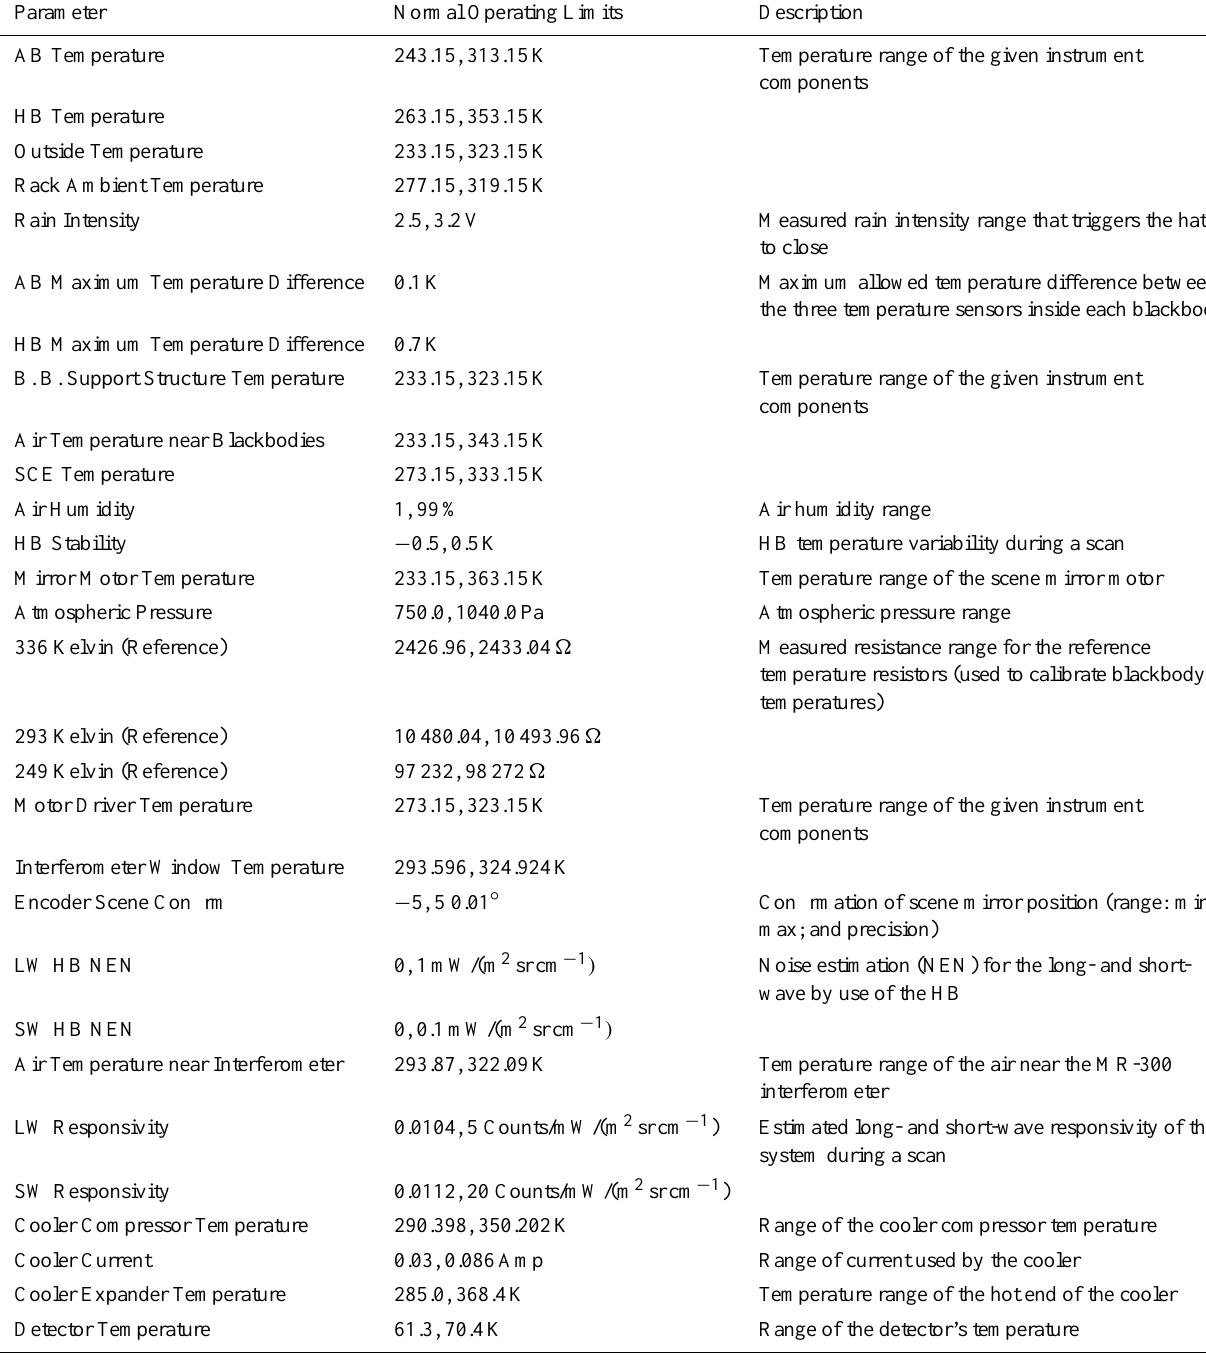
Table 1. Parameter metrics used when monitoring the status of the E-AERI. The normal operating range customized for operation at Eureka lies between the limits